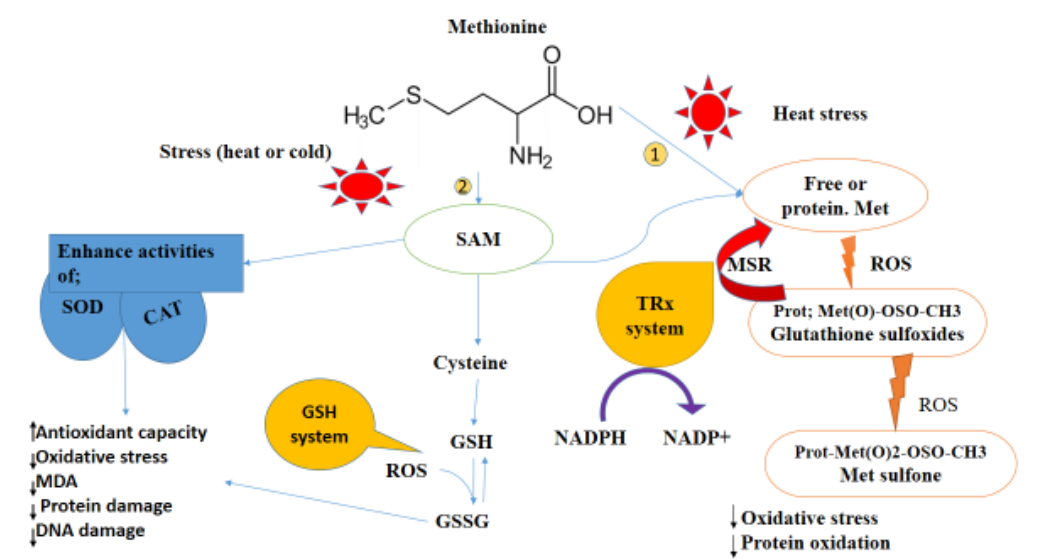
Figure 3. Role of dietary Met and free/protein-bound Met in the poultry antioxidant system under heat stress. Adapted from [66–68]. (1). Through the involvement of Met residues in proteins during ROS oxidation. Methionine’s sulfur side chain is oxidized by reactive oxidative species, which may cause Met sulfoxide to undergo additional oxidation to form methionine sulfone under prolonged exposure to ROS. Methionine sulfoxide reductase can convert methionine sulfoxide back into Met, but it cannot convert methionine sulfone. (2). Activation of antioxidant enzymes (SOD and CAT) and production of GSH, which reduce oxidative stress caused by heat stress through Met metabo- lites.